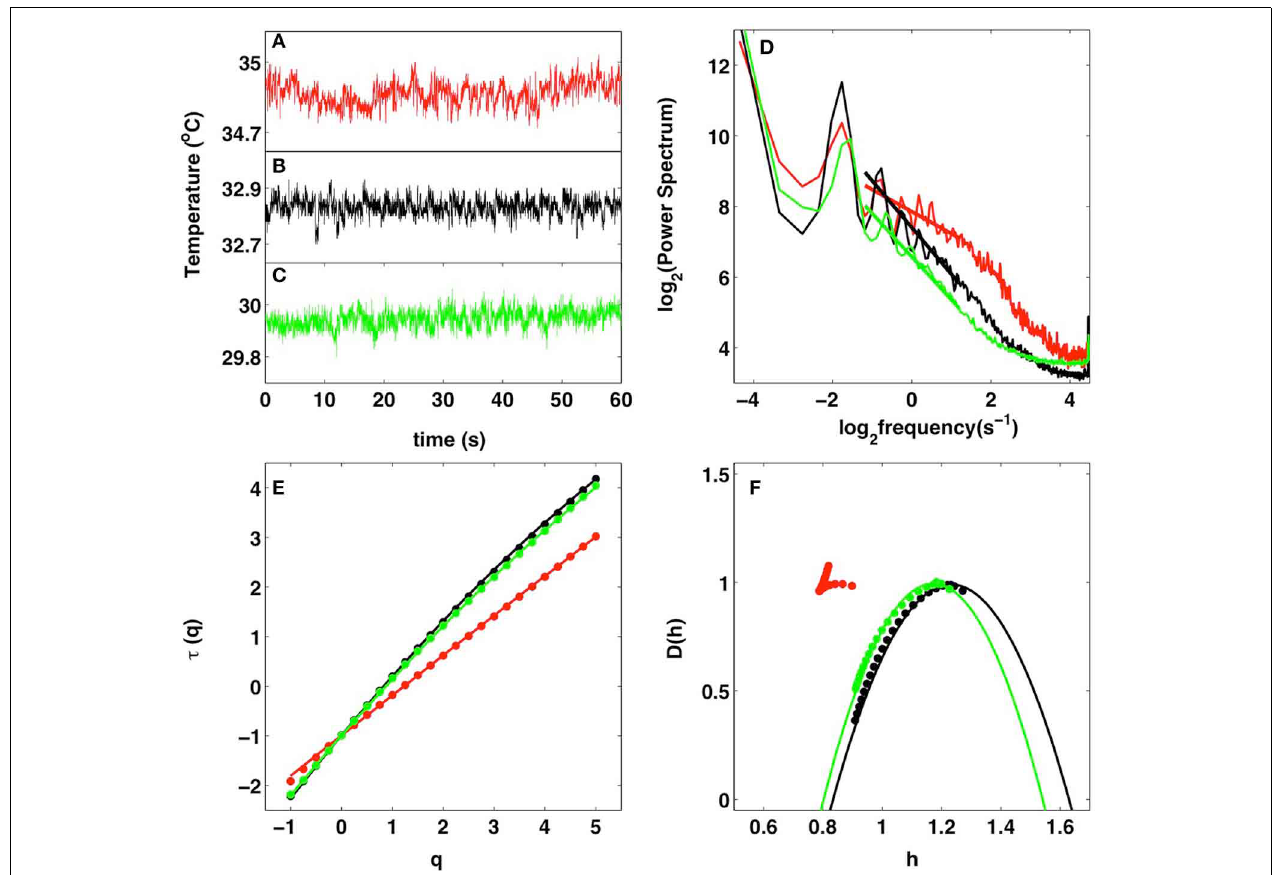
estimated with the WTMM method in (E) . (E) τ ( q ) vs. q estimated by linear regression fit of log 2 Z ( q , a ) vs. log 2 a over a range of time-scales [0.3, 3]s ( Figure 2A ). (F) D ( h ) vs. h ( Figures 2B,C ). The solid lines in (E,F) correspond to quadratic spectra (see text) with parameters [ c 0 , c 1 , c 2 ] = [ 0 . 99 , 0 . 81 , 0 . 0044 ] (red), [ 0 . 99 , 1 . 23 , 0 . 080 ] (black), and [ 0 . 99 , 1 . 171 , 0 . 069 ] (green). In (E,F) , the τ ( q ) and D ( h ) spectra were averaged over a 8 × 8 pixel 2